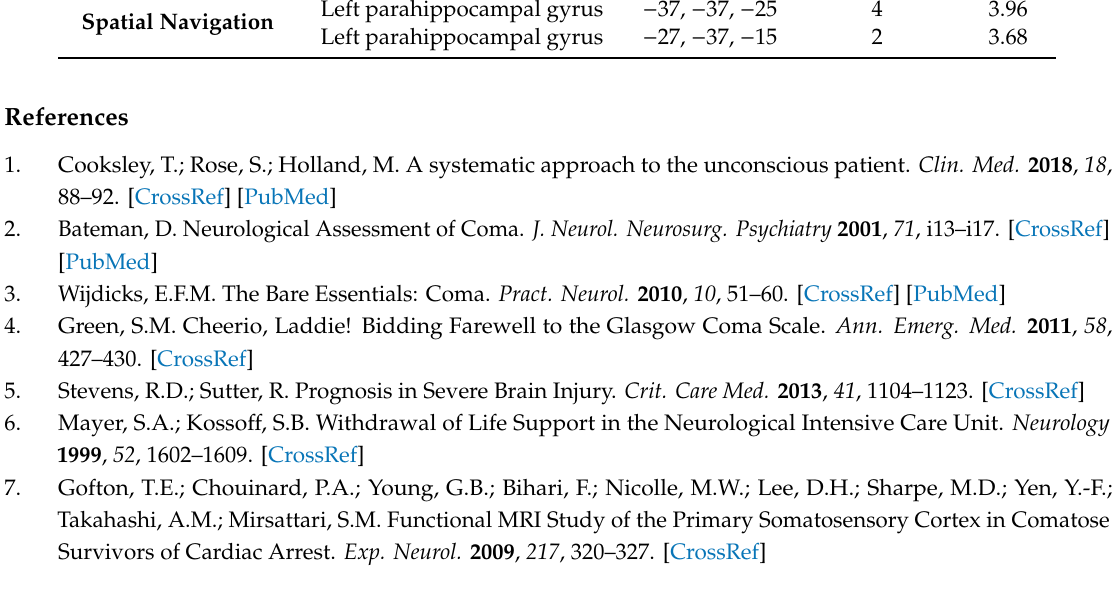
Table A3. Peak voxel activity when assessing for di ff erences between the recovery and acute scan. Paradigm Brain Region Speech